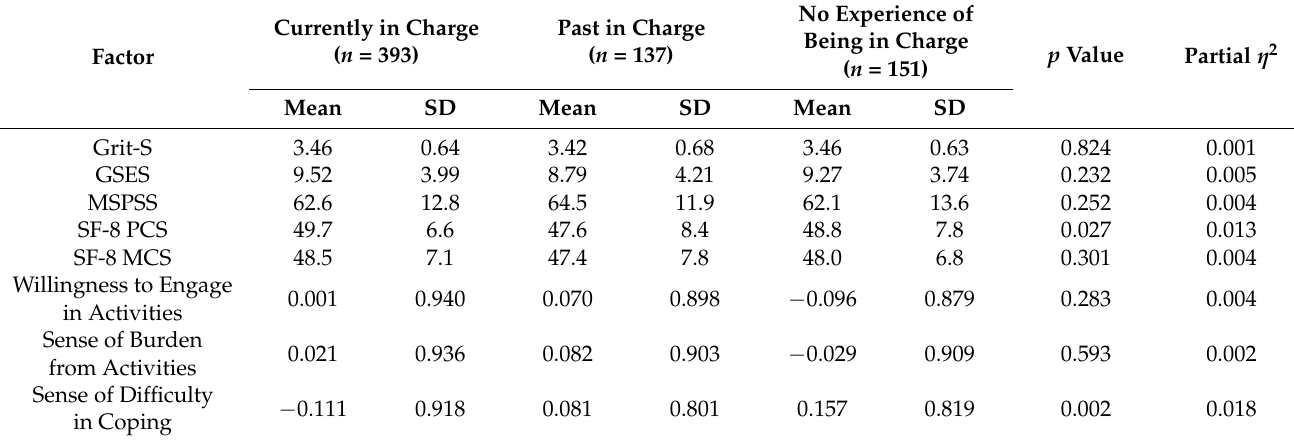
Table 5. Relationship between the experience of night shift and factors related to willingness to engage in activities.